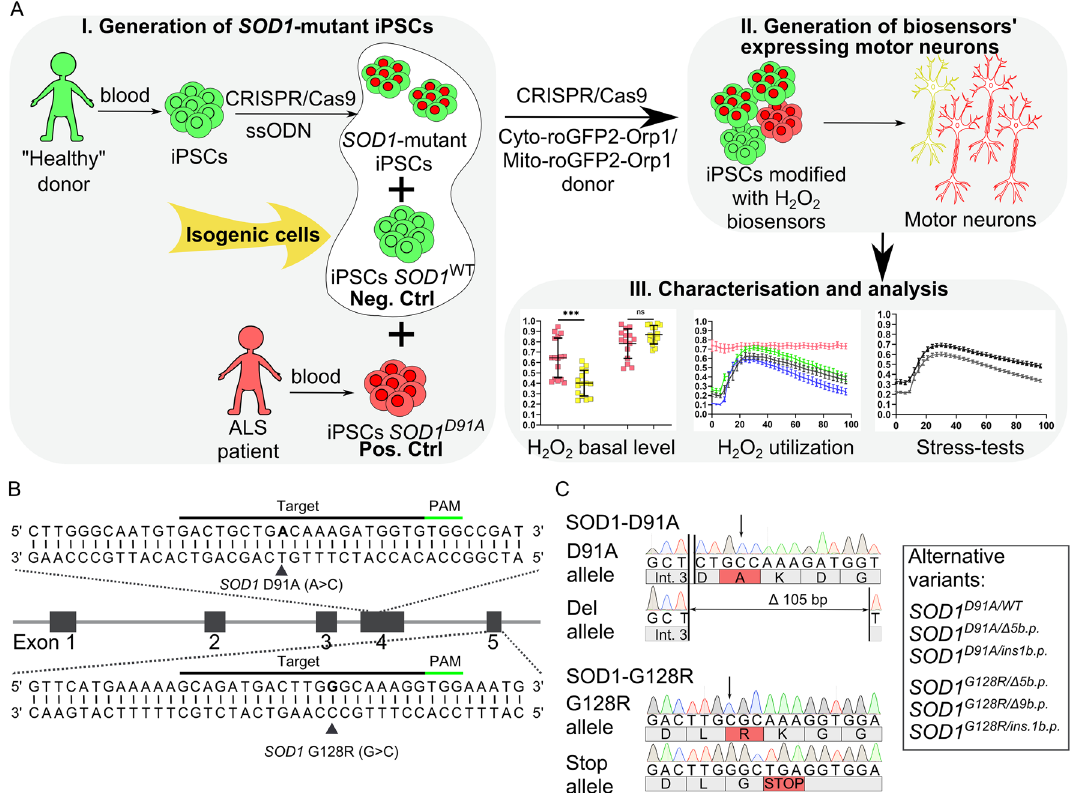
Figure 1. Generation of isogenic SOD1 -mutant iPSC lines. ( A ) Schematic representation of the experimental design. Induced pluripotent stem cell (iPSC) lines with SOD1 mutations were generated either from iPSCs of a healthy donor by CRISPR/Cas9-mediated genome editing or obtained from a patient with ALS. The iPSCs from a healthy donor served as an isogenic negative control (Neg. Ctrl); patient-specific iPSCs served as a positive control (Pos. Ctrl). Next, the iPSC lines (control, SOD1 -mutated, and patient-specific) were modified with biosensors of cytoplasmic (Cyto-roGFP2-Orp1) and mitochondrial (Mito-roGFP2-Orp1) H 2 O 2 by targeted insertion of the biosensors’ sequences with CRISPR/Cas9. Then, the modified iPSC lines were differentiated in spinal motor neurons with subsequent analysis of the redox state of the neurons with the biosensors. ( B ) Schematic of the SOD1 gene with partial sequences of exons 4 and 5. Protospacers designed for CRISPR/Cas9- mediated double-stranded breaks are underlined with black lines, protospacer adjacent motif (PAM)—with green lines; target mutations are in bold and marked with black triangles. ( C ) Partial SOD1 sequences of exons 4 and 5 of the SOD1-D91A and SOD1-G128R iPSC lines. Int. 3—intron 3, substituted nucleotides marked with an arrow, corresponding mutated amino acids are highlighted in red. The box contains a list of clones with alternative SOD1 variants obtained in the